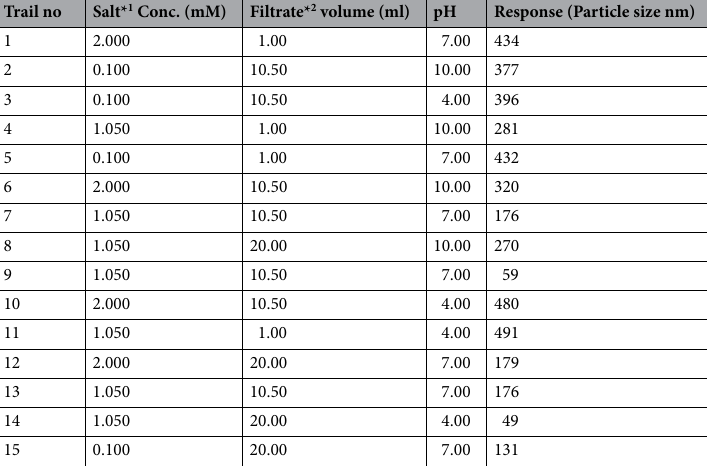
Table 2. Matrix of Box-Behnken design employed for optimizing size of iron nanoparticles produced by Aspergillus flavipes (MN956655.1). * 1 FeSo 4 ·7H 2 O. * 2 Aspergillus flavipes MN956655.1 Culture filtrate.